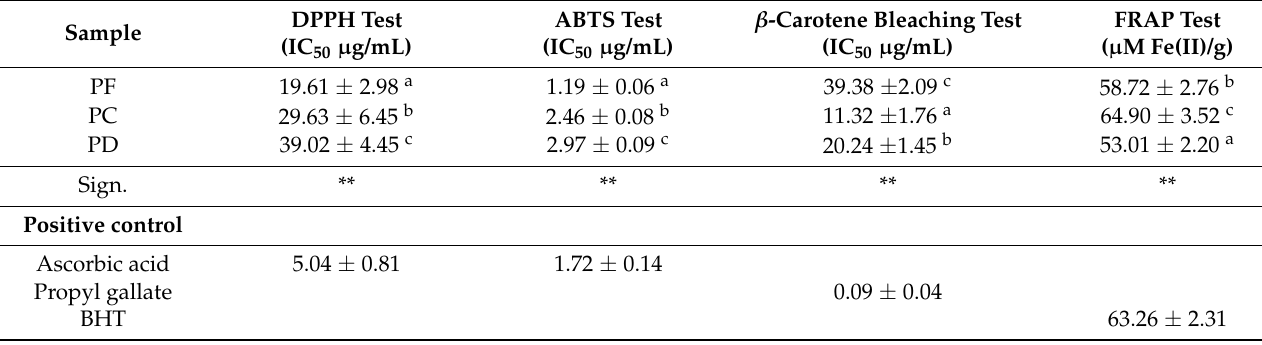
Table 5. ‘Alimena’ Myrobalan Antioxidant